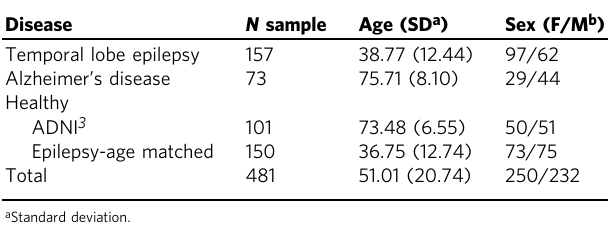
Table 1 Demographic summary.